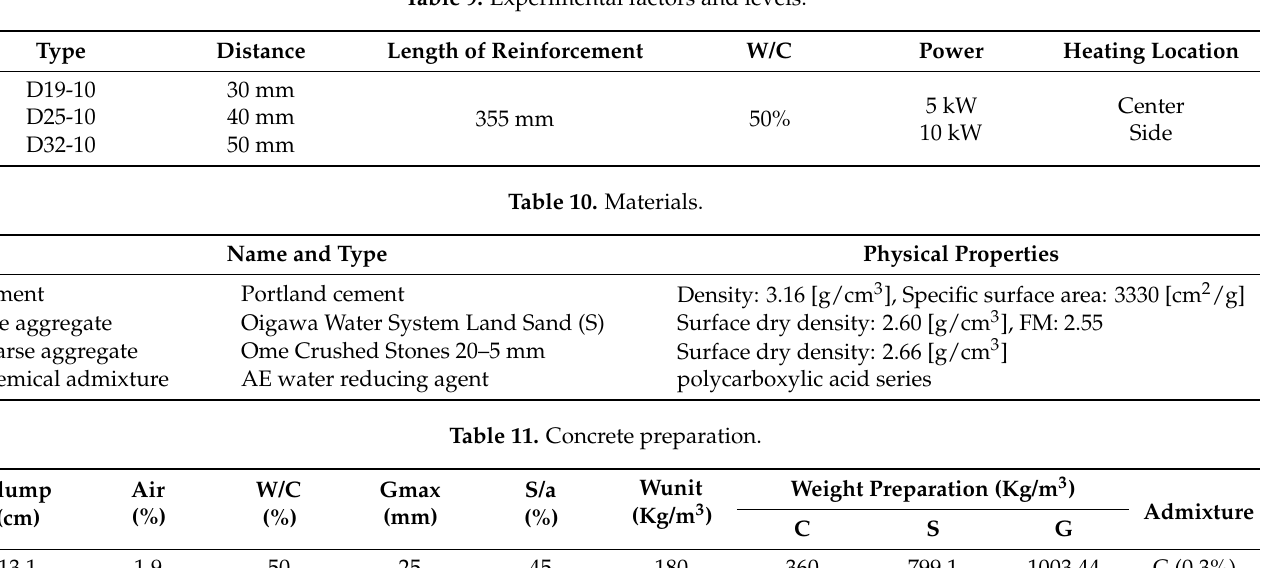
Figure 20. Results of rebar recovery experiment by induction heating. Table 9. Experimental factors and levels.